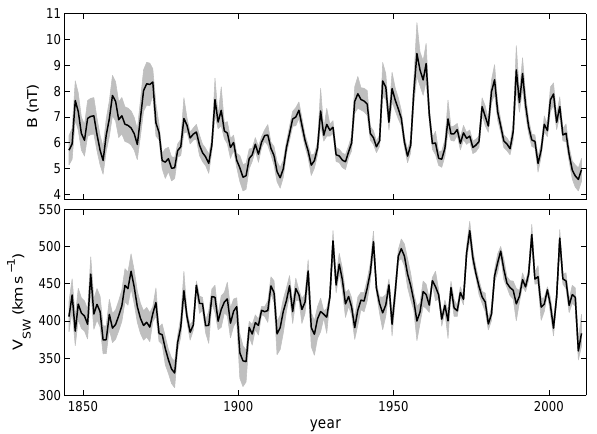
Fig. 8. Time series of (top) IMF B predicted by geomagnetic ac- tivity indices and (bottom) solar wind speed, V SW . The black lines are the best estimates and the grey bands show the uncertainty at the 2 σ (95%) level as derived from plots like Fig. 7. All four index pairings ( aa C and IDV(1d), aa C and IDV, IHV and IDV(1d) and IHV and IDV) contribute to both the best estimates and the uncer- tainties after 1890. Before 1890 IHV is not available. In addition, the problems highlighted with IDV before 1872 in Paper 3 mean it is not used in this interval and the reconstruction is based on aa C and IDV(1d) alone and the uncertainties are derived from those es- timated for these two geomagnetic indices by comparison with data from nearby stations (principally St